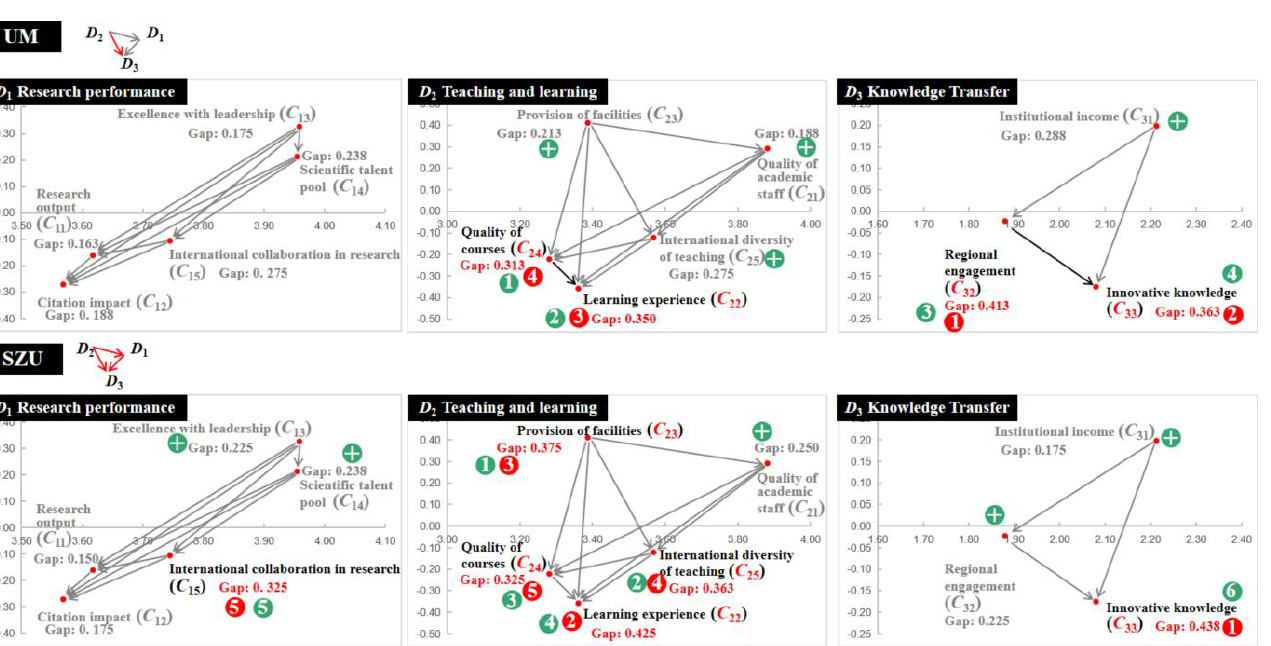
Figure 4. Improvement priorities for the UM and SZU. Note: The red dots represent the criteria with the lowest performance (i.e., those with gap values of 0.3 or higher) and the numbers on the red dots indicate the order in which the gap values are arranged (highest to lowest). The green dots represent the improvement priority of the criteria according to the influential network relationships; “+” represents collocation criteria for improving the criteria with the lowest performance.